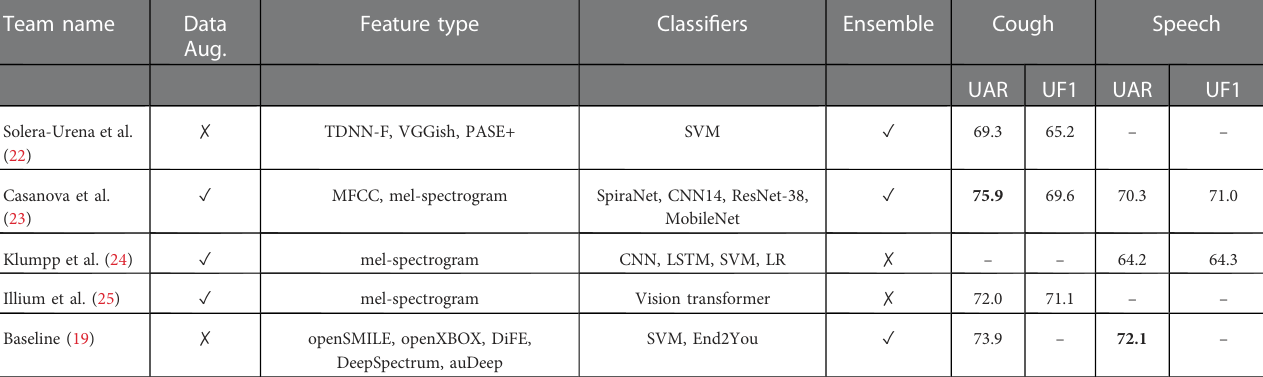
TABLE 2 Summary of methodologies used in accepted papers at Interspeech 2021 along with their classi fi cation performance. Unweighted Average Recall (UAR) and Unweighted Average F1 (UF1) metrics are provided [%]. Team